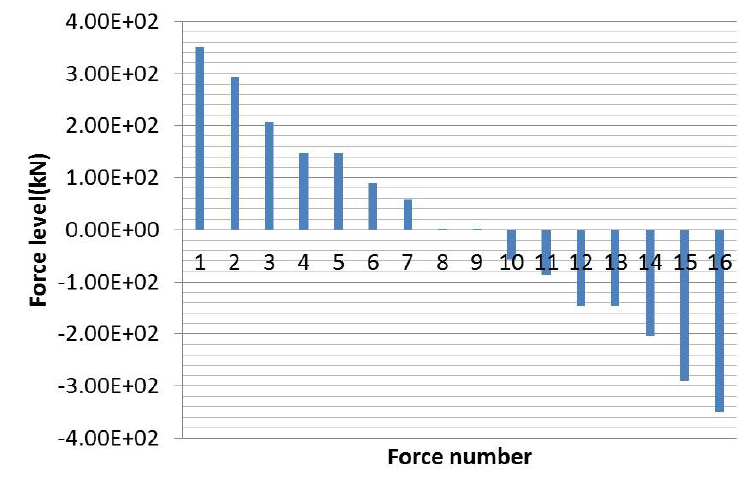
Figure 6. An example for all discrete possible values for a PTO